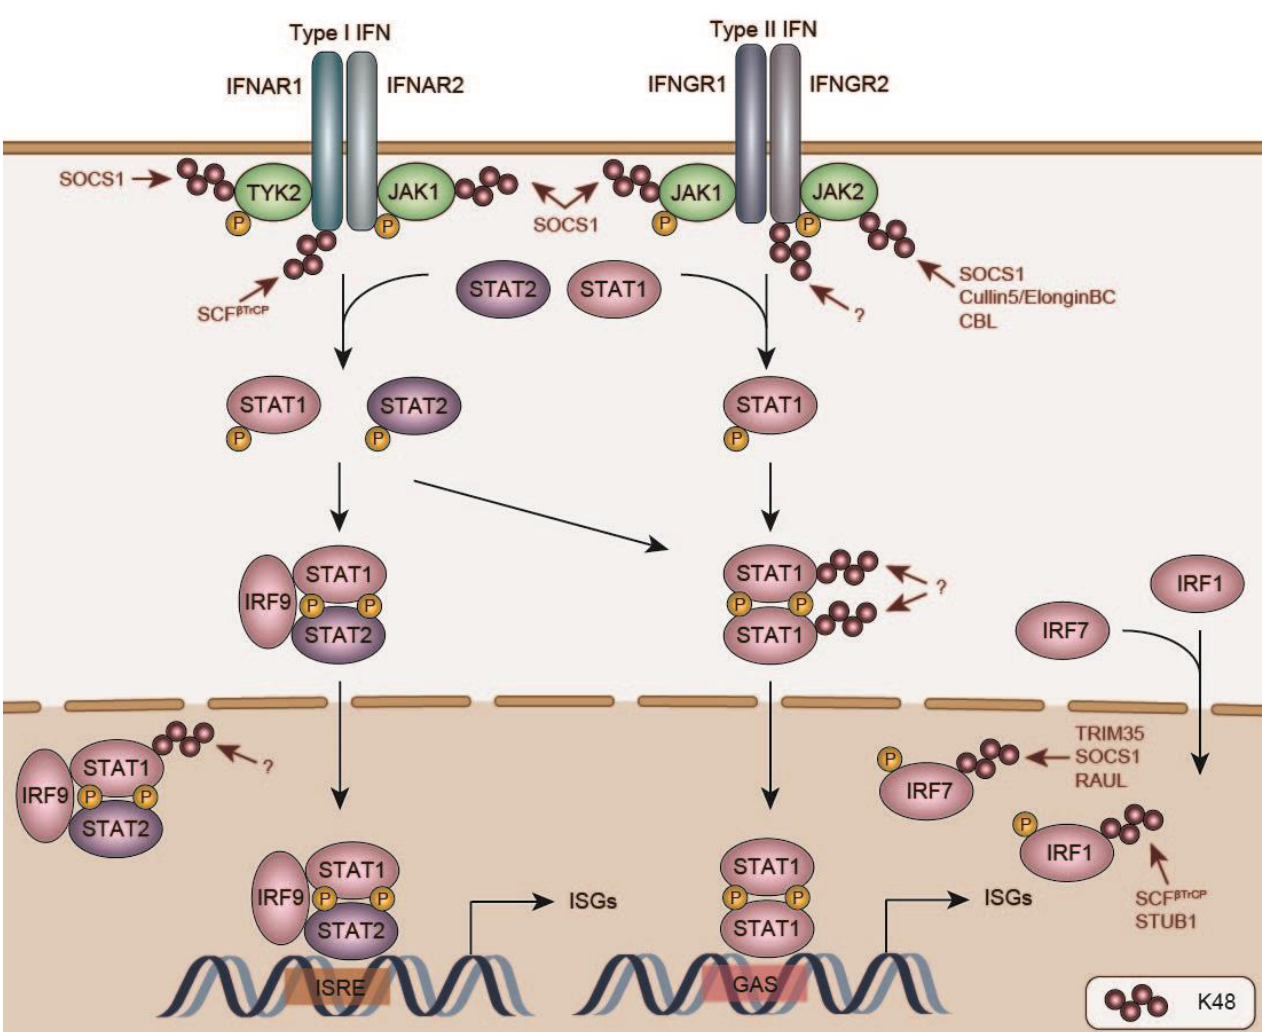
Figure 3. Negative regulation of type I and II IFN signaling. Type I IFNs (IFNα/IFNβ) bind to the IFN Alpha Receptor (IFNAR)1/2 receptor complex. This in turn activates the Janus Kinase 1 (JAK1) and Tyrosine Kinase 2 (TYK2) kinases, which phosphorylate Signal Transducer and Activator Of Transcription 1 (STAT1) and STAT2, resulting in the formation of the heterotrimeric Interferon Stimulated Gene Factor 3 (ISGF3) complex consisting of STAT1/STAT2/IFN-Regulatory Factor 9 (IRF9). Upon translocation to the nucleus, this transcription factor complex drives the expression of several hundred IFN-induced genes (ISG), which harbor an IFN-stimulated Response Element (ISRE) in their promoter regions. In contrast, type II IFN (IFNγ) binds the IFNGR1/2 complex, resulting in JAK1/2 activation, STAT1 phosphorylation, and STAT1 homodimerization. STAT1 homodimers translocate to the nucleus, and associate with Gamma-Associated Sequences (GAS) in the promoters of IFN-Stimulated Genes (ISG). The two illustrative ISGs — IRF1 and IRF7 — are shown. E3 ligases adding degradative K48 chains are displayed in dark red.